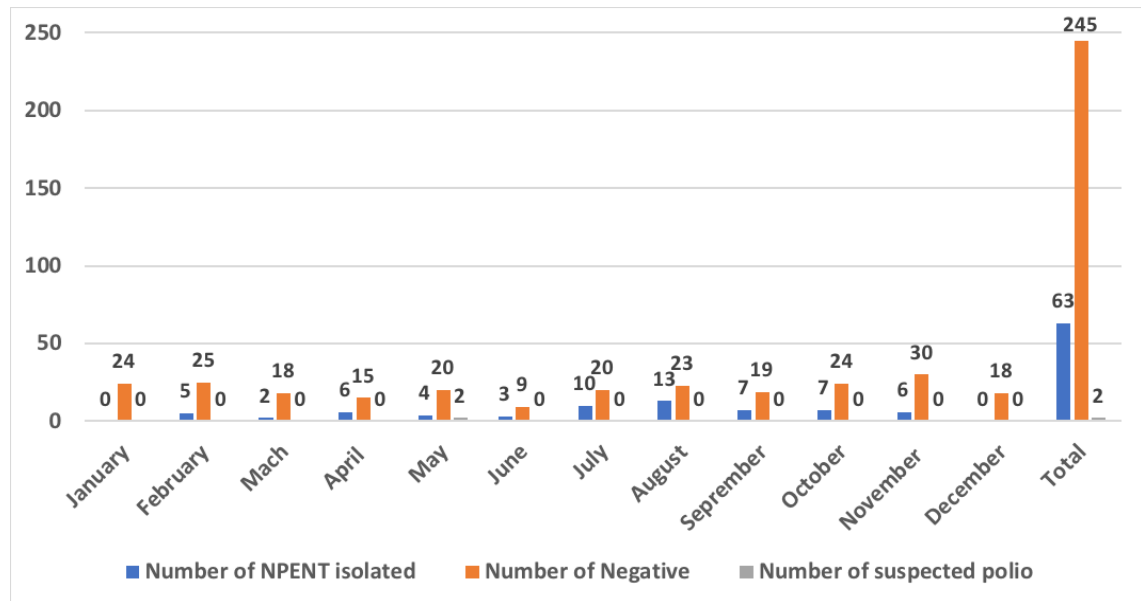
Figure 2. Temporal distribution of the selected stool samples in our study from January to December 2017 according to the cell culture results. The diagram bars highlighted in blue indicate the total number of isolated non-polio enteroviruses, while those color-coded in orange represent the number of samples that tested negative through the process used in our study. The samples suspected for polioviruses are highlighted in grey.